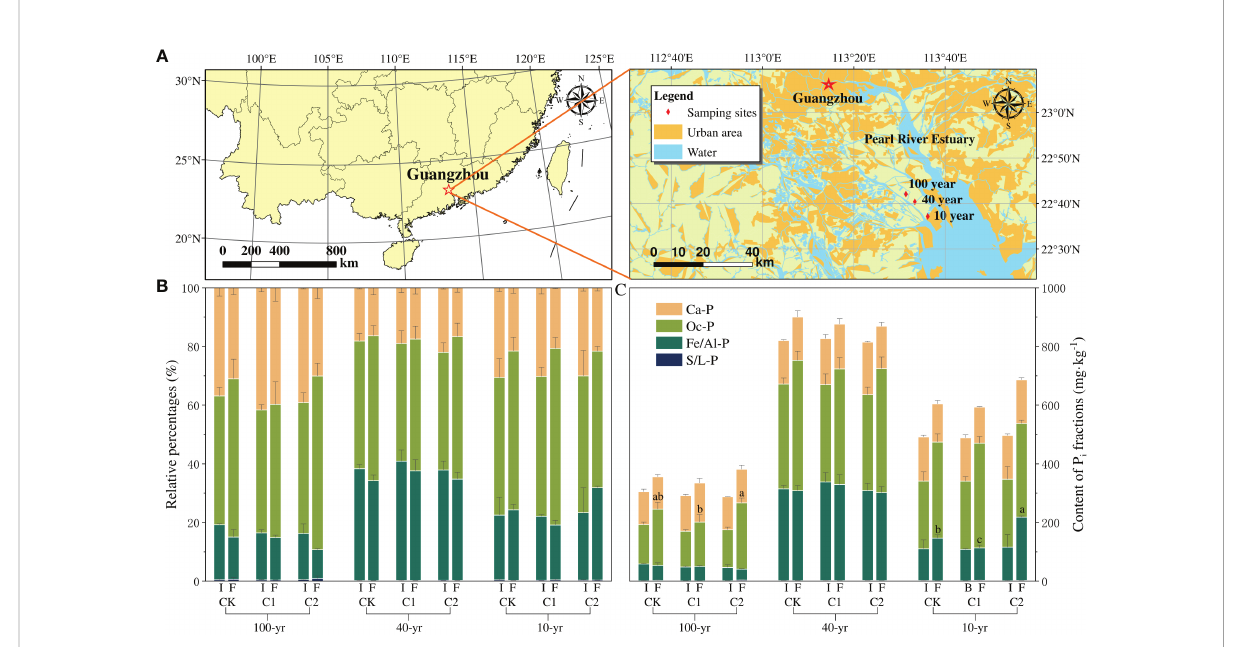
FIGURE 1 (A) Location map of sampling sites in the Pearl River Estuary. The percentages (B) and contents (C) of P 100-year reclaimed soils under different Cd addition treatments. Data represent the mean ± SE (n = 3). ‘ I ’ and ‘ F ’ represent initial incubation on day 0 and fi nal incubation on day 40, respectively. Different lowercase letters indicate signi fi cant differences among different Cd addition treatments ( P < 0.05). Groups that are not marked with a letter mean no signi fi cant difference ( P >